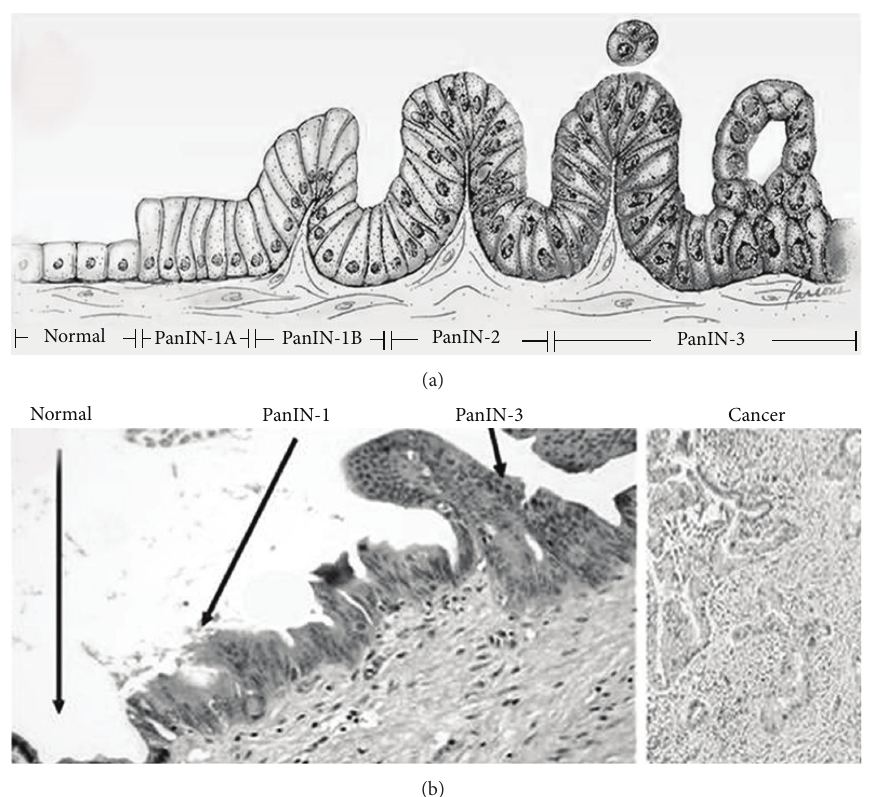
Figure 3: Histological progression from normal pancreatic cells to pancreatic intraepithelial neoplasia [3]. (a) Model for histological progression from normal pancreatic cells to pancreatic intraepithelial neoplasia (PanIN). (b) Micrograph of normal pancreas, pancreatic intraepithelial neoplasia (PanIN), and pancreatic cancer (PC) [from Wikipedia]. Gradual transition from PanIN-1 to PanIN-3 was observed in a single duct. Haematoxylin and eosin